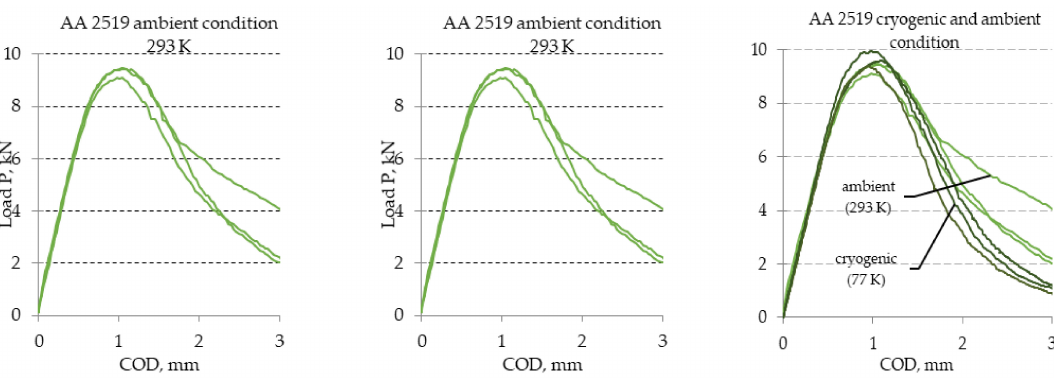
Figure 7. Diagram of load-COD determined during tests of maximal experimental value of stress intensity factor K Q determined for aluminium alloy AA2519 under ambient and cryogenic